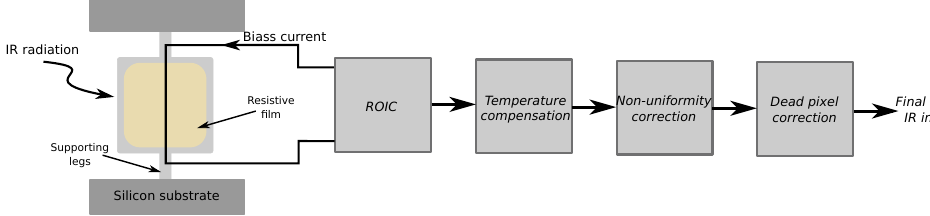
Figure 1. Resistive microbolometer read-out and raw ADC value